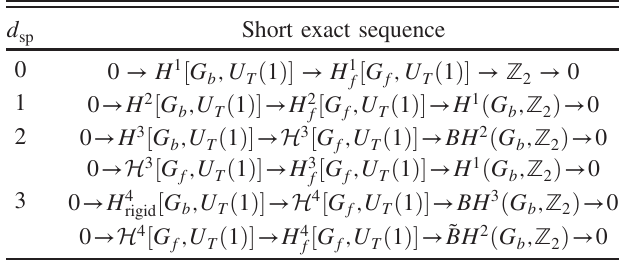
TABLE I. Classifying FSPT phases up to spacial dimension 3 with a total symmetry G d G × Z f 2 using a general f ¼ b sp ¼ group supercohomology class computed from short exact 1 Þ(cid:2) is the so-called special ; U sequences. Note that H d sp þ 1 ½ G f T ð group supercohomology proposed in Ref. [42], and that in lower 0 , 1, we have H d sp þ 1 dimensions with d ½ G f ; U T ð 1 Þ(cid:2) ≡ sp ¼ f